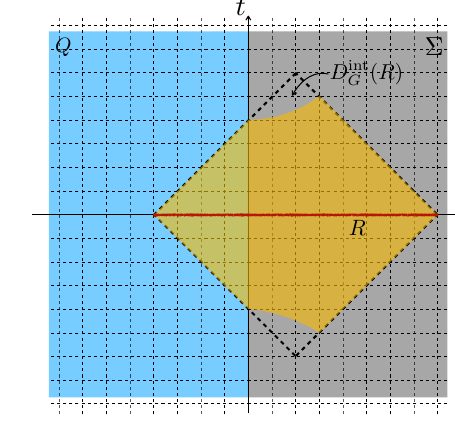
( R ) is the region surrounded G ( R ) . Therefore, C ( R ) ⊃ D int ( R ) T G